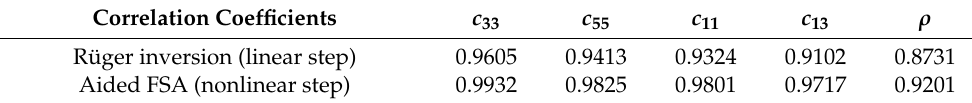
Table 1. Correlation coefficients of the inversion results in Figure 10a,c and the true models.